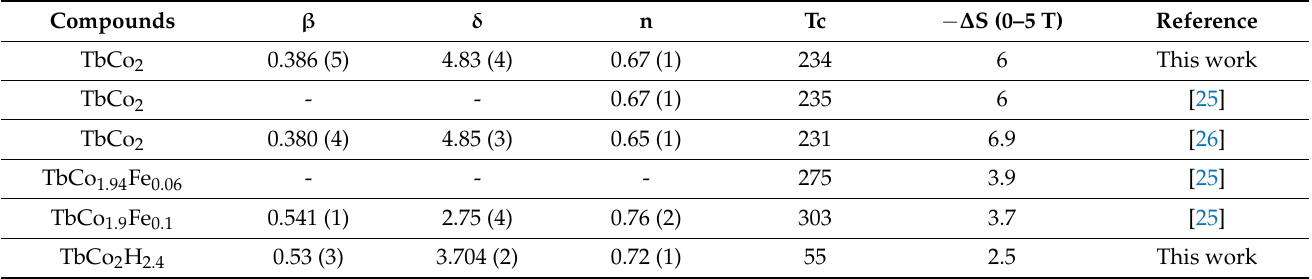
Figure 6. Critical exponent analysis of TbCo 2 -H for: ( a ) Critical isotherm of M vs. B of TbCo 2 H 2.4 close to the Curie temperature Tc = 55 K. Inset shows the same on log – log scale and the straight line is the linear fit following Equation (4); the critical exponent δ is obtained from the slope of the linear fit. ( b ) Critical isotherm of −Δ S vs. B of TbCo 2 close to the Curie temperature Tc = 230 K and TbCo 2 H 2.4 close to the temperatures T = 25 and 55 K. Inset shows the same on log – log scale and the straight line is the linear fit following Equation (5); the critical exponent n is obtained from the slope of the linear fit. Table 1. Critical exponents β , δ and n, Curie temperature T C and maximum change of magnetic en- tropy | − ∆ S| at 0–5 T, for the TbCo 2 , substituted compounds Tb(Co,Fe) 2 and the hydride TbCo 2 H 2.4